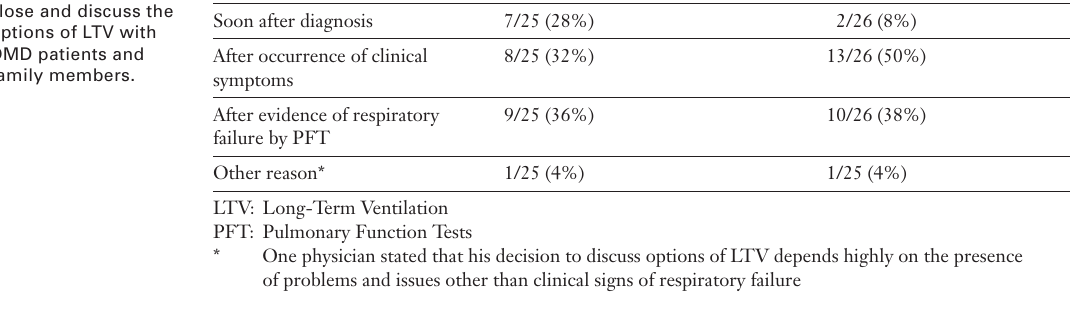
Practice of surveyed physicians to dis- close and discuss the options of LTV with DMD patients and family members.